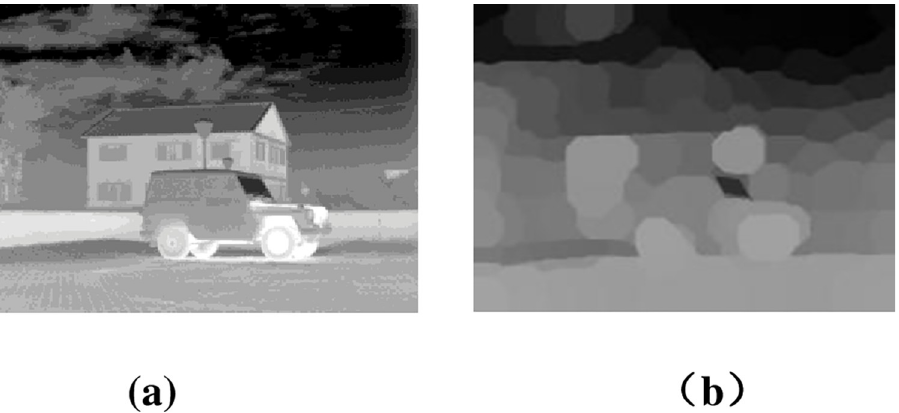
Fig 2. Example of the multi-scale decomposition (a) source image, (b) the proposed multi-scale